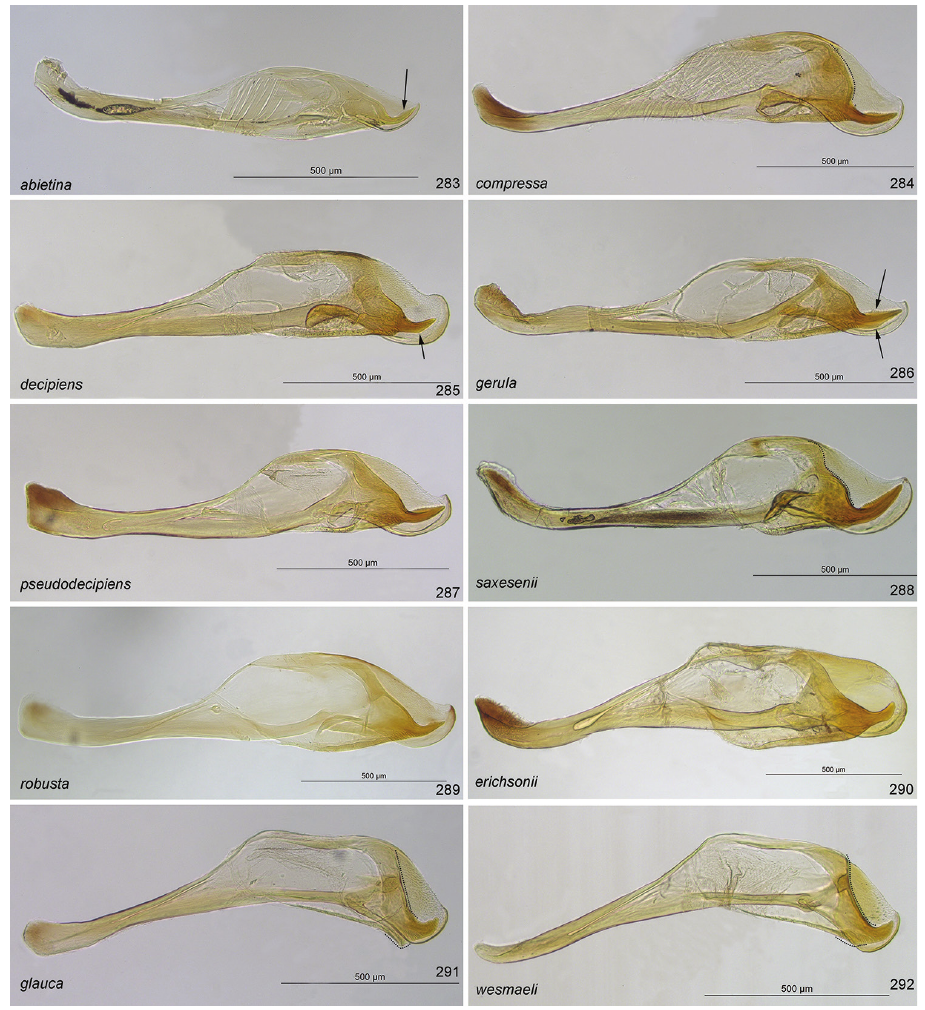
Figures 283–292. Penis valves of Pristiphora . 283 abietina PR.285VV (arrow indicates a thin non-serrate margin of valvispina) 284 compressa DEI-GISHym31607 285 decipiens DEI-GISHym31585 (arrow indi- cates angled middle part of valvispina) 286 gerula DEI-GISHym31601 (arrows indicate dorsal and ventral thinned and serrate margins of valvispina) 287 pseudodecipiens DEI-GISHym31586 288 saxesenii DEI- GISHym31547 289 robusta PR.621VV 290 erichsonii DEI-GISHym80353 291 glauca DEI-GISHym17724 292 wesmaeli